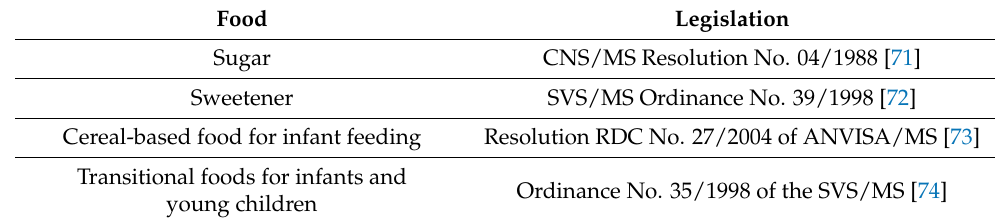
Table 2. Foods in which the use of dyes is not